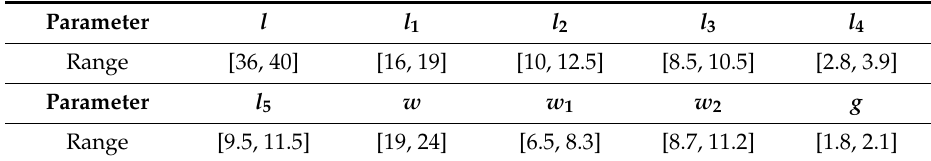
Table 1. Initial Ranges of Design Parameters.